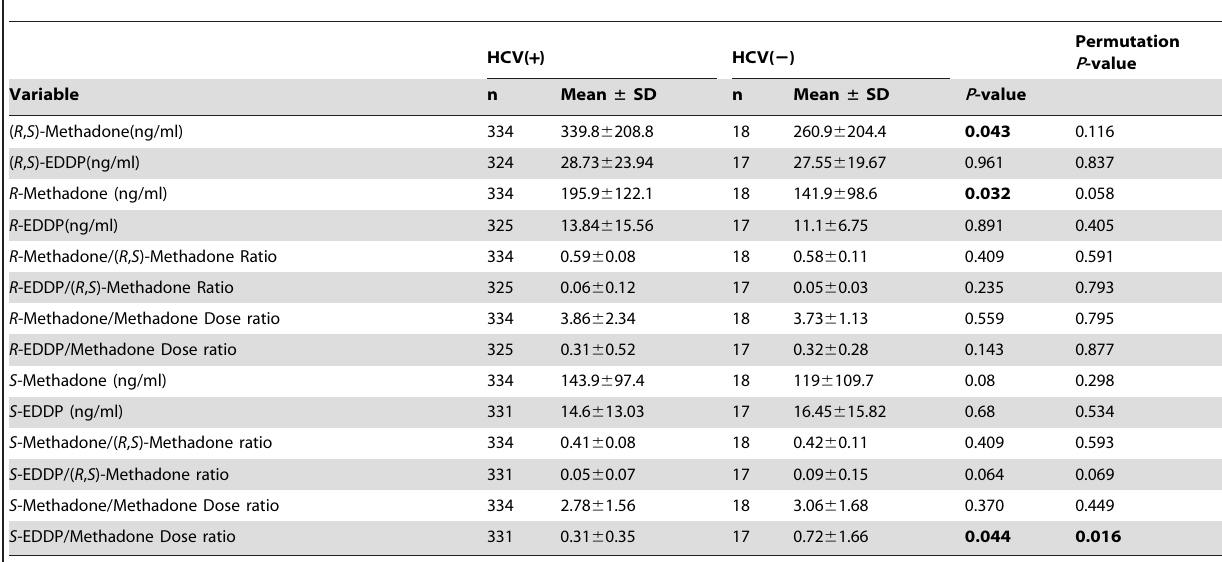
Table 2. Methadone and its metabolism between the HCV antibody-positive and antibody-negative MMT subjects.